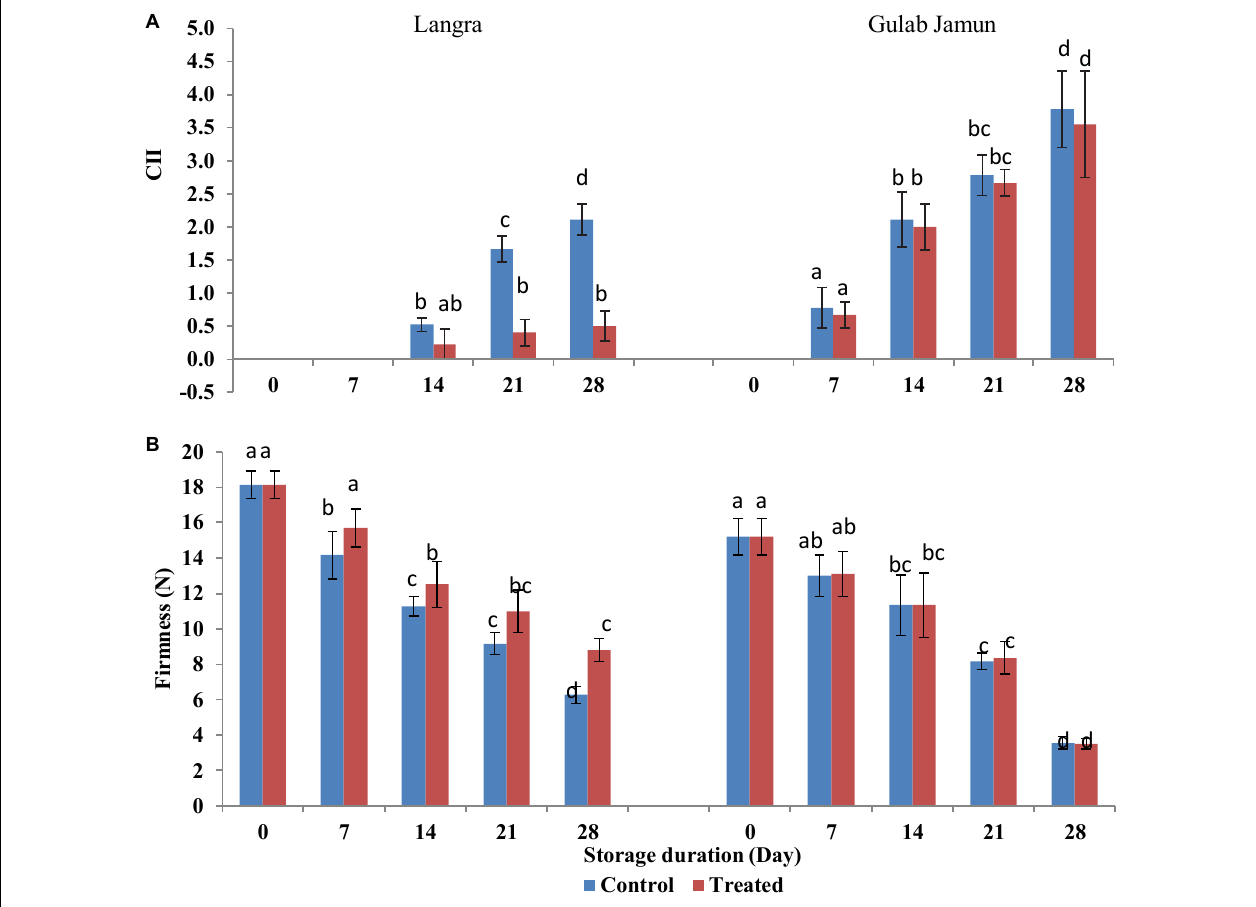
FIGURE 1 | (A) Chilling injury index (CII), (B) firmness in ‘Langra’ and ‘Gulab Jamun’ mango fruit treated with 0 µ M (control) or 100 µ M (treated) MT for 2 h followed by storage at 5 ± 1 ◦ C. Readings were taken on every 7 days of 5 ± 1 ◦ C storage followed by 3 days of shelf life at room temperature (25 ◦ C, 90–95% RH). Each value is the mean for three replicates and vertical bars indicate the standard error. Error bars with different small letters on the same storage period show a significant difference ( P ≤ 0.05).